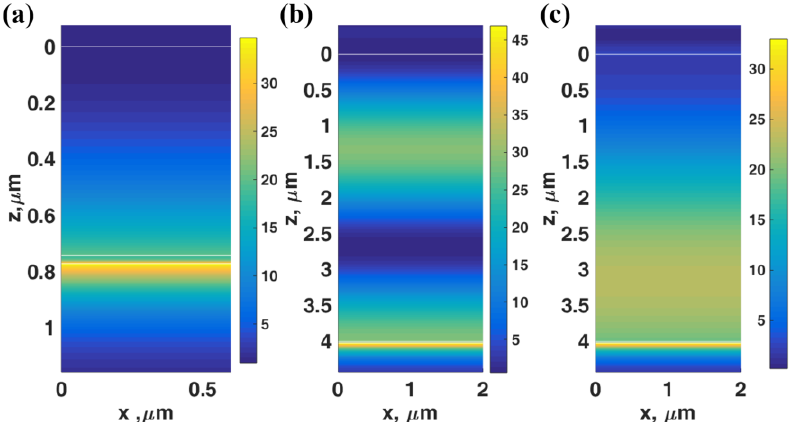
Figure 6. Field distributions of |H y | 2 for ( a ) the LRSPP excited by the evanescent wave coupling labelled ‘C’ in Figure 5, ( b ) the LRSPP excited by the 1st order ( M = 1) labelled ‘D’ in Figure 5b and ( c ) the LRSPP excited by the 0th order ( M = 0) labelled ‘E’ in Figure 5b.